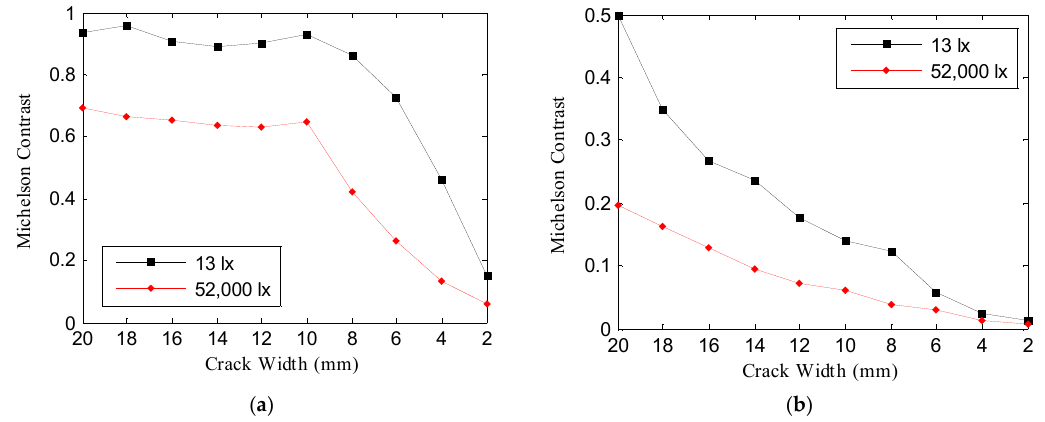
Figure 17. Comparison of Michelson contrast of crack images acquired at 13 lx and 52,000 lx, Shooting distance: ( a ) 25 m, ( b ) 100 m.